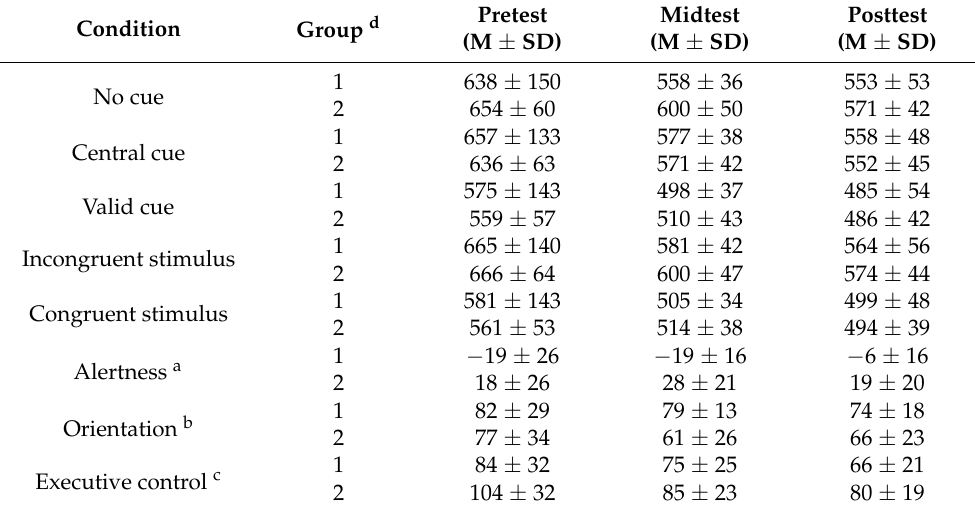
Figure 3. Effect (difference scores) with standard error (SE) for the three attentional subfunctions on RT. Table 2. Response time in the attention task (RT in ms).